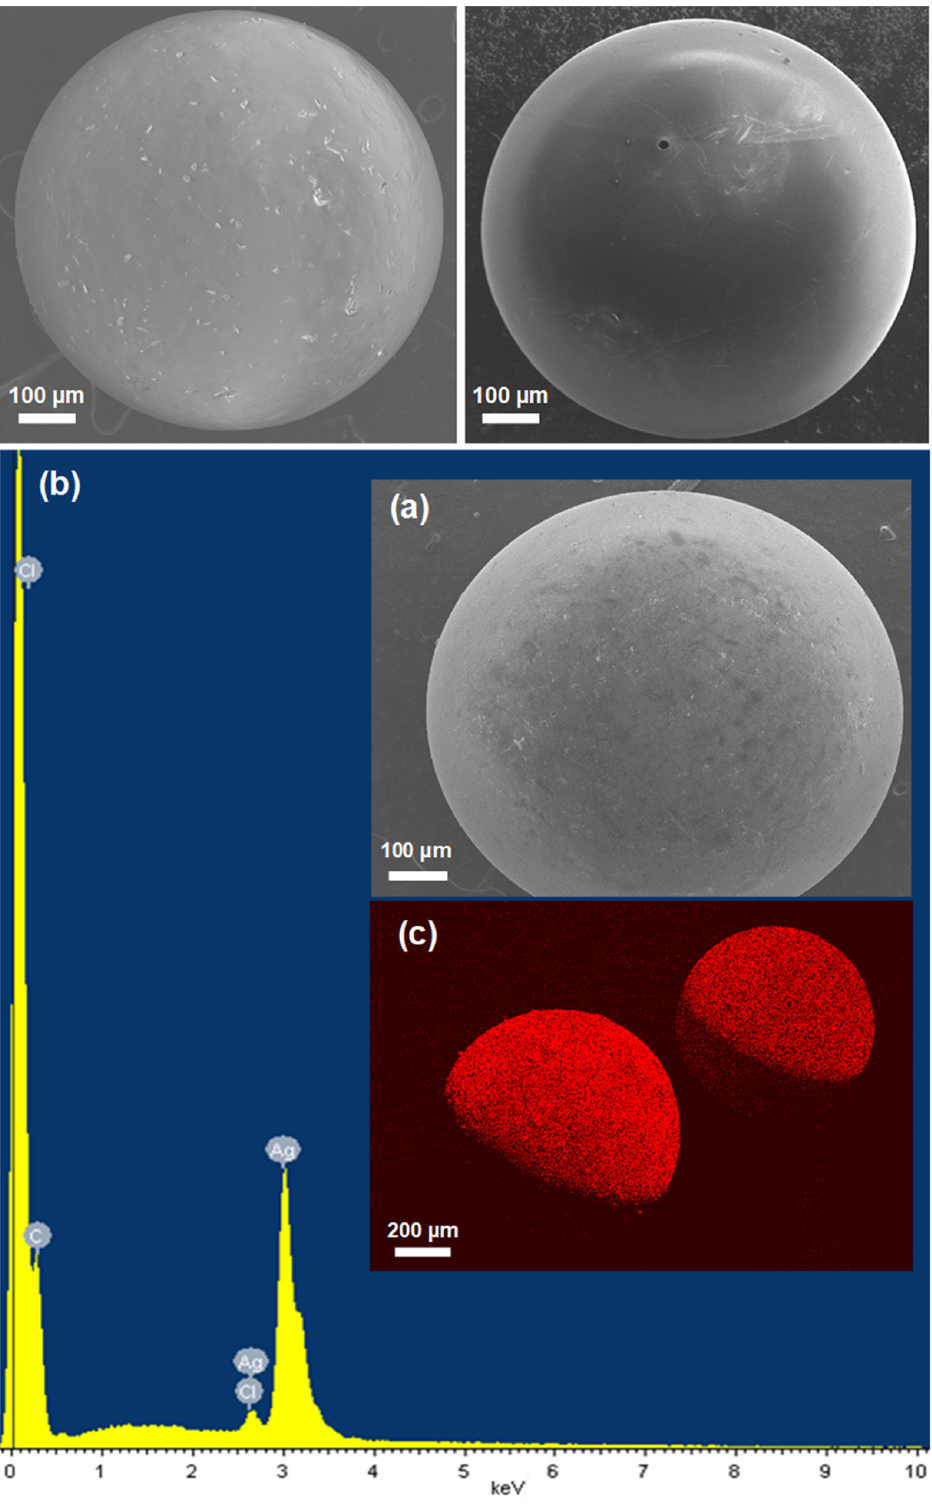
Figure 3. Top: Representative SEM images of the original unloaded resin beads. Bottom: Repre- sentative SEM image ( a ) and EDS spectrum ( b ) and mapping ( c ) for Ag element on the resin beads embedded with Ag